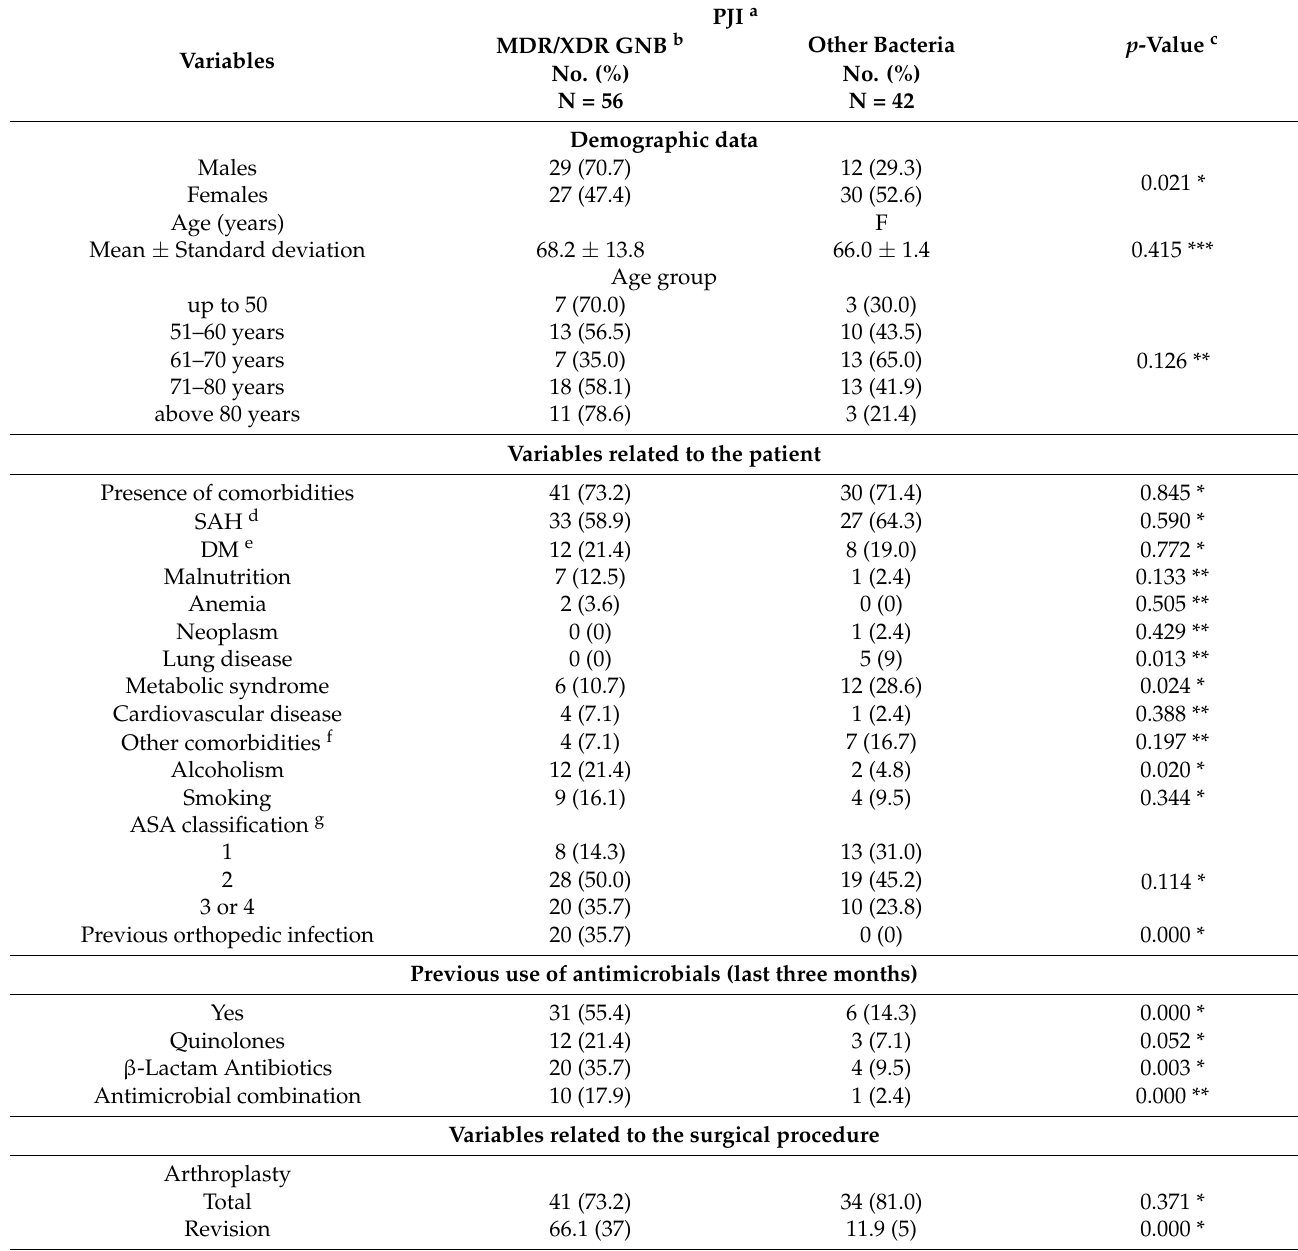
Table A1. Evaluation the influence of variables of interest on the outcome of PJI caused by MDR- GNB compared to other bacteria–univariate